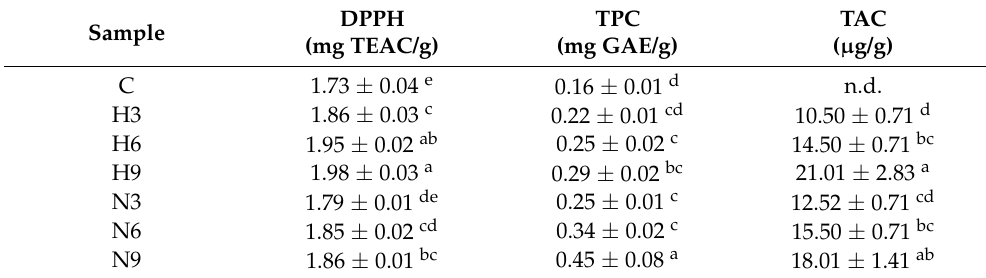
Table 3. Results of antioxidant activity, total polyphenol, and anthocyanin